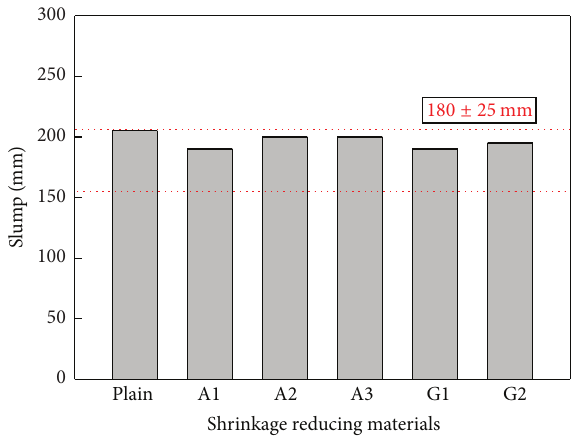
Figure 1: Relationship between the slump and the shrinkage reducing